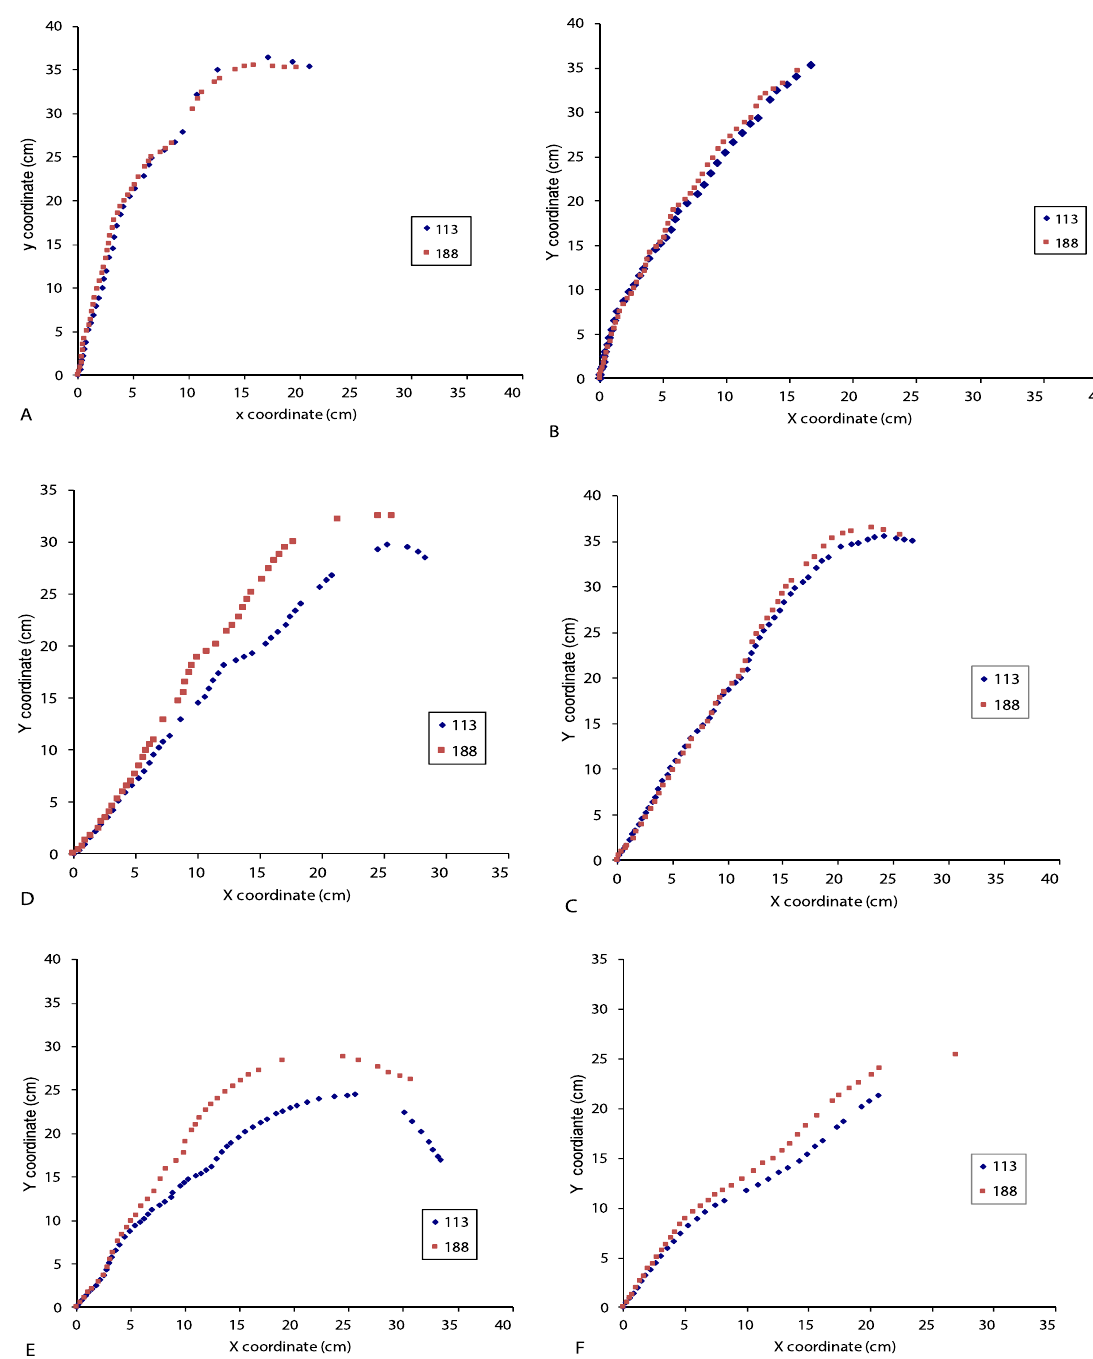
Fig 7. Beech seedling shapes just after tilting and at photogravitropic equilibrium in an anisotropic light environment, for different values of initial tilting. Initial shape (blue symbols) and shape at photogravitropic equilibrium (red symbols) obtained by photo digitizing with Image J. Dates of photos are indicated on the graph (Julian days). A, B: Pots were tilted 5˚ and 15˚ from the vertical, respectively. No movement could be detected. C, D: Pots were tilted 25˚ from the vertical. Tree exhibited no movement (C), or movement (D). E, F: Pots were tilted 35˚ from the vertical. Trees exhibited a visible movement spread throughout the stem length.